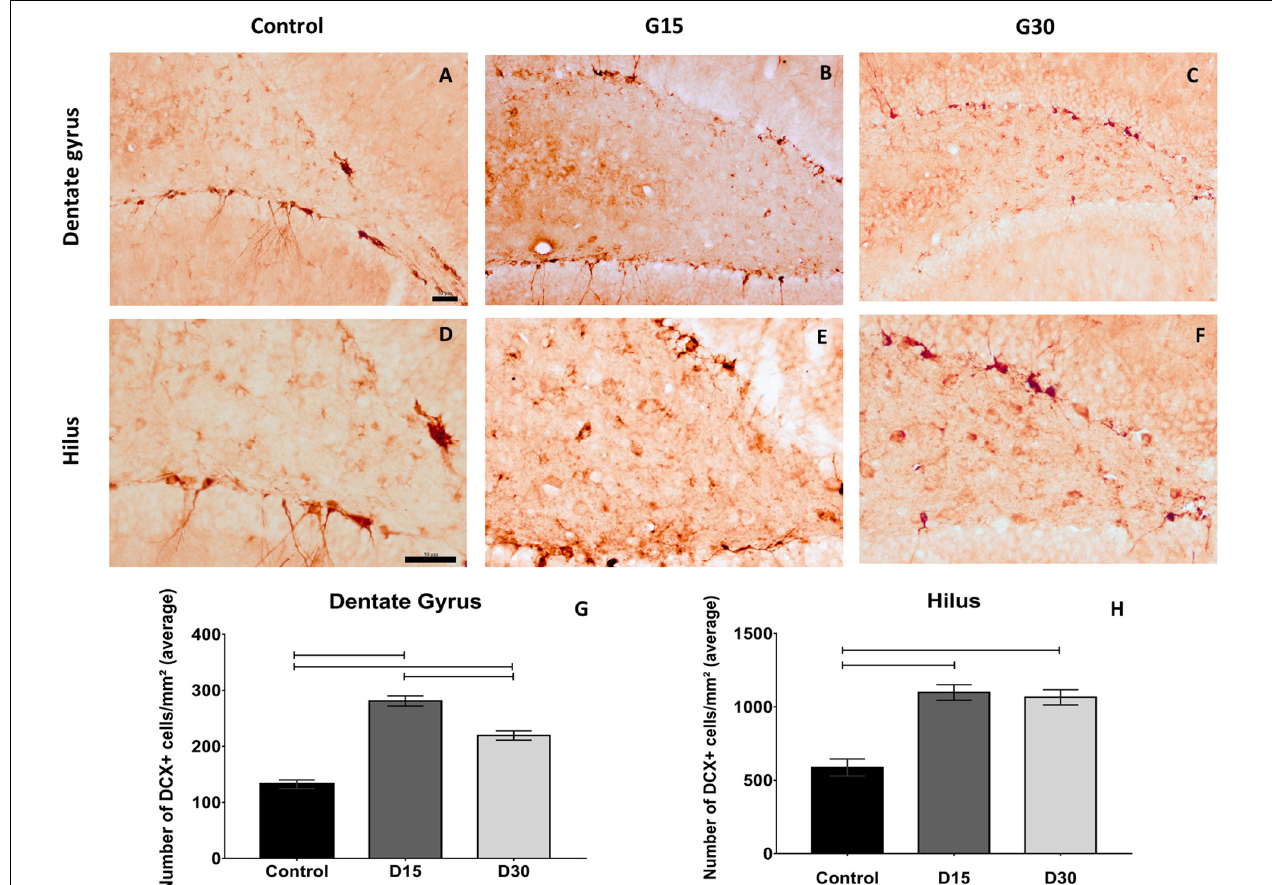
FIGURE 2 | Compensatory increase in rat hippocampal neurogenesis after unilateral hippocampectomy. Immunolabeling for doublecortin (DCX) in coronal sections from animals belonging to all experimental groups (control, G15, and G30). There was an increase in the number of neuroblasts in both dentate gyrus (B,C) and hilus (D–F) compared to that of control (A,D) . This has been confirmed by the quantitative analysis [ (G,H) Kruskal–Wallis with Dunn’s post hoc test (dentate gyrus); one-way ANOVA with Tukey’s posttest test (hilus), p < 0.01]. Scale bars: 50 µ m; (A–C) objective X20; (D–F) objective X40.